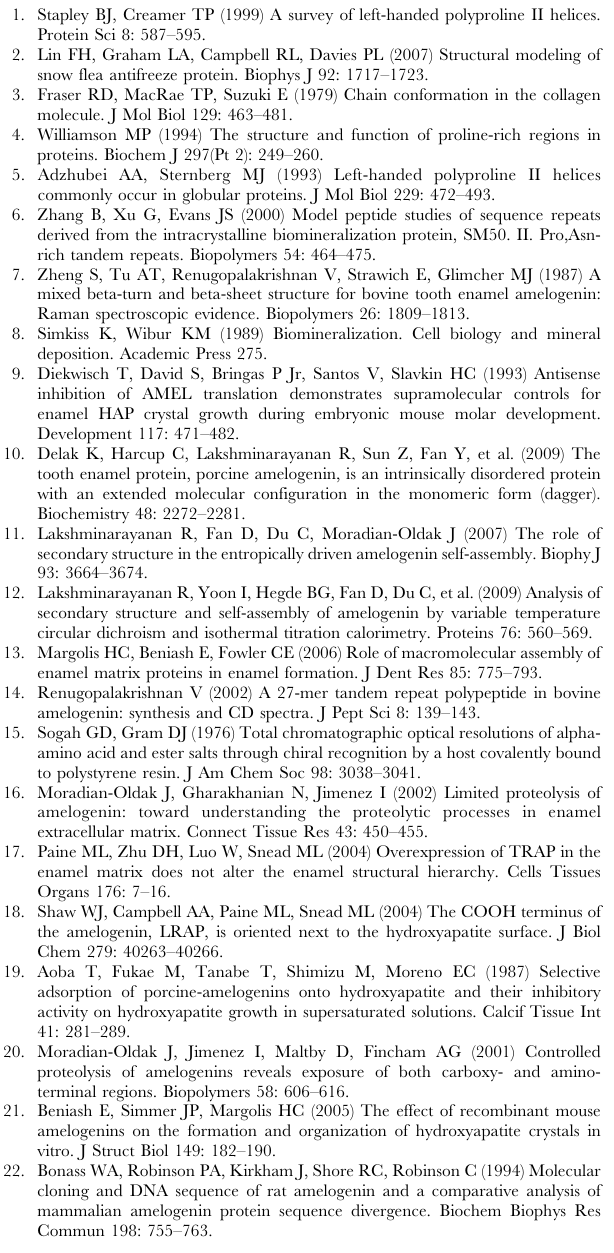
Table S2 Detected NOEs of the PXX33